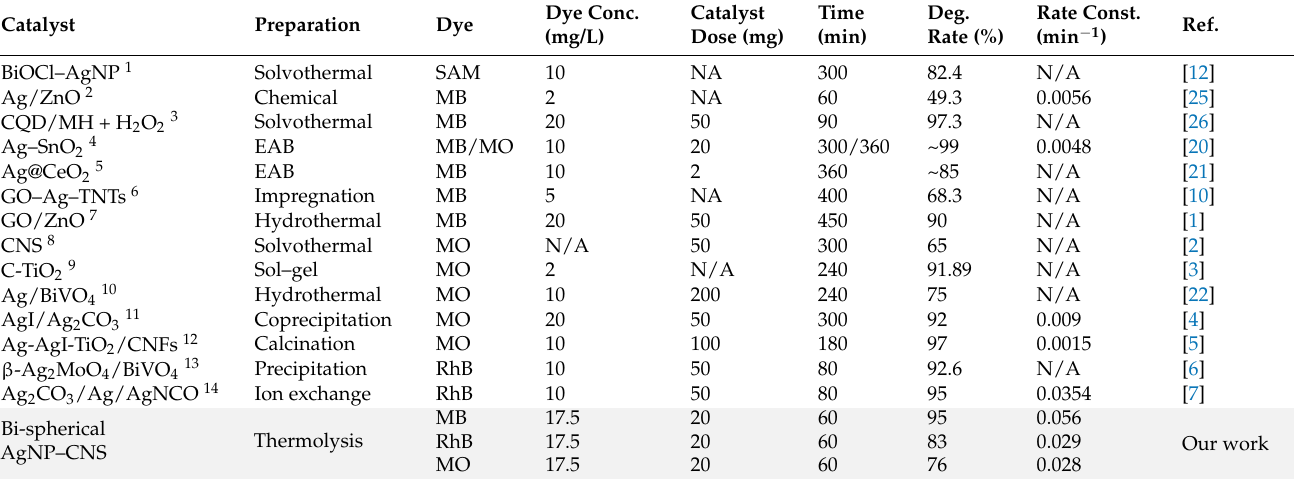
Table 2. Comparative efficacy of the AgNP–CNS nanocomposite and previously reported